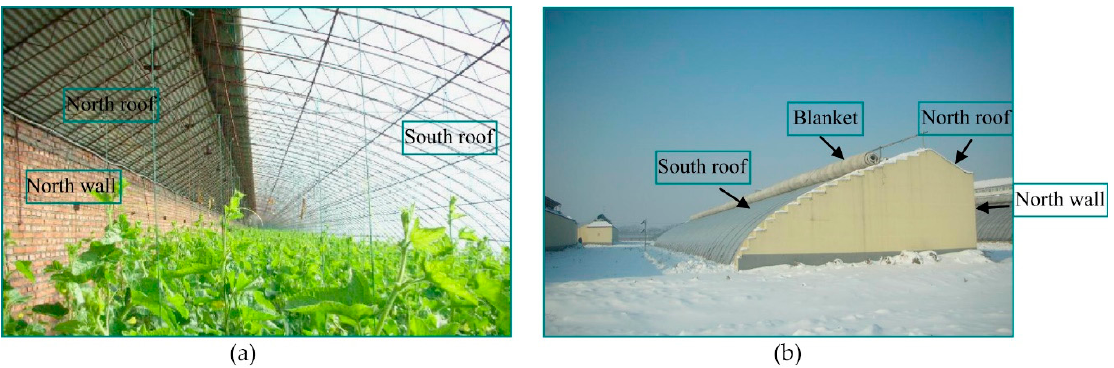
Figure 1. Pictures of the ( a ) inside and ( b ) outside of a Chinese-style solar greenhouse (CSG)